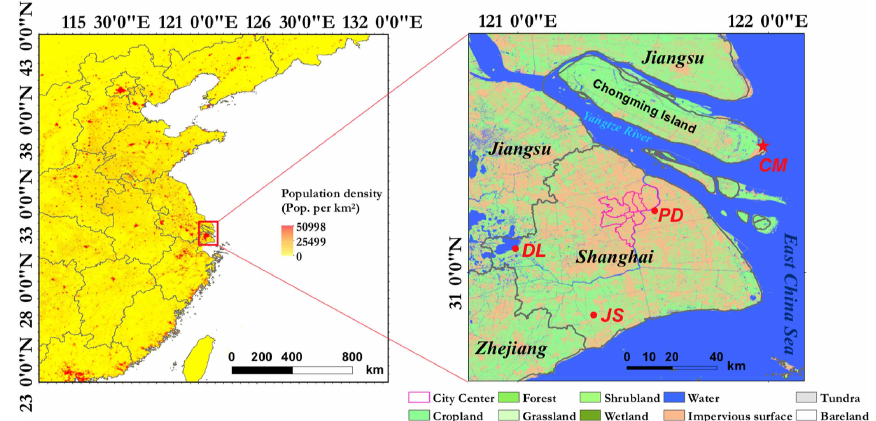
Figure 1. Location of the sampling site. Population density is color-coded in the left panel. The right panel shows the land cover in Shanghai (adapted from Peng et al., 2018). CM (Chongming) is the sampling site on the island of Chongming. JS (Jinshan) represents the source emission from a dairy farm in rural Shanghai. DL (Dianshan Lake) represents a regional transport region in the Yangtze River Delta. PD (Pudong) represents the urban site.